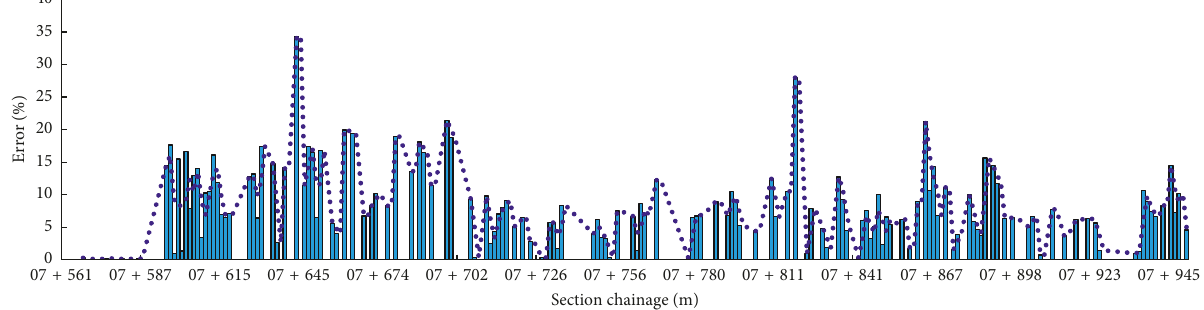
Figure 15: Error analysis